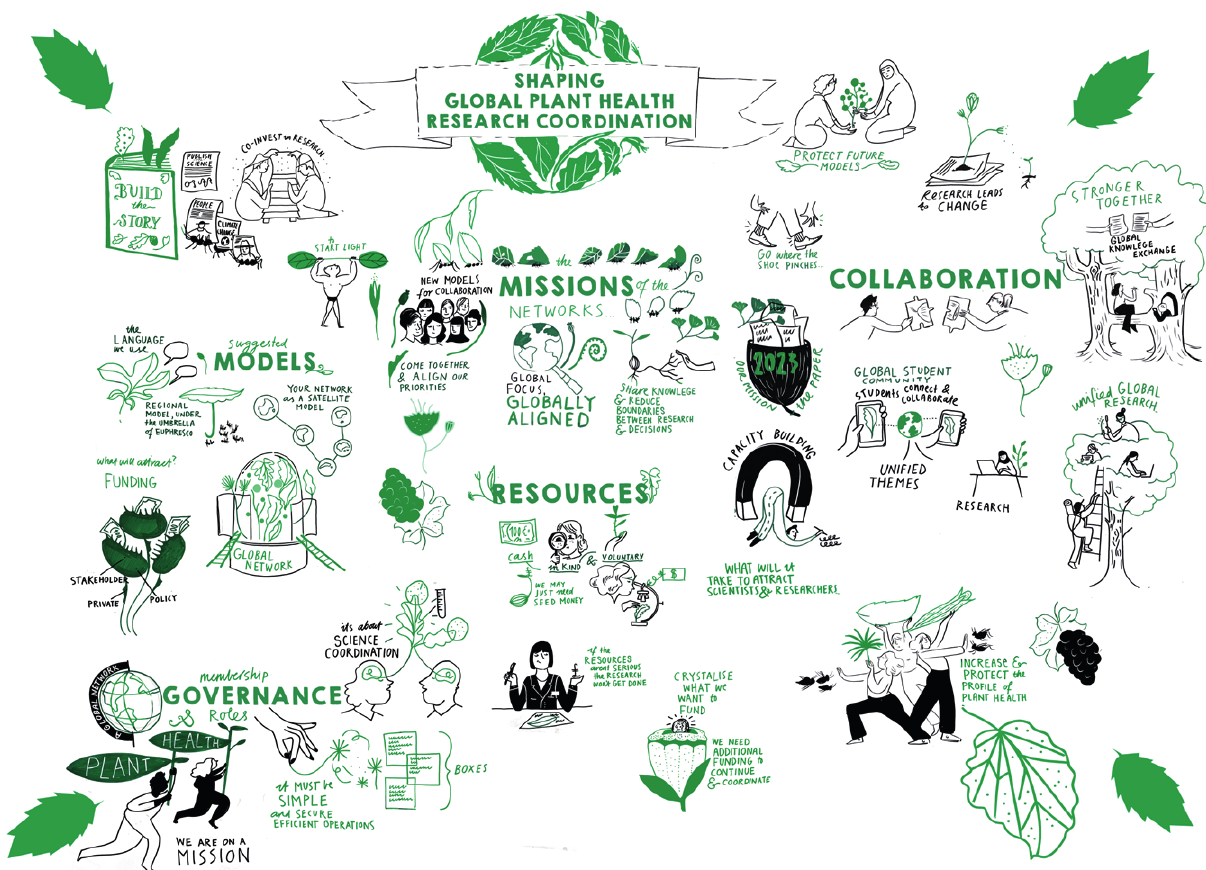
Figure 2. Transcription and illustration (by Josephine Ford) of the main topics discussed during the Euphresco B3 PBRI workshop, held in London (United Kingdom), on 20 September,